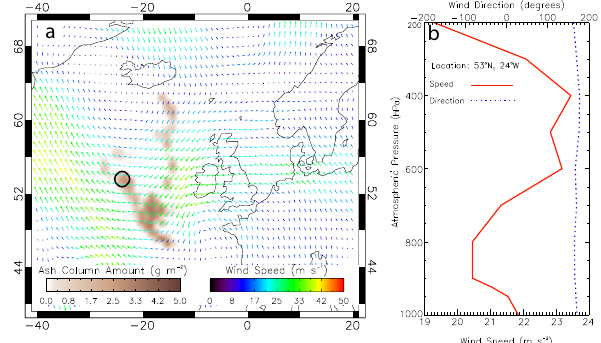
Figure 6: a) ECMWF reanalysis data for 12:00 UTC on May 7 at 500hPa with the coincidental SEVIRI ash retrieval underlain. b) Vertical profile of wind speed and direction taken from the ECMWF wind data at 53° N, 24° W, location indicated by the black circle in a).